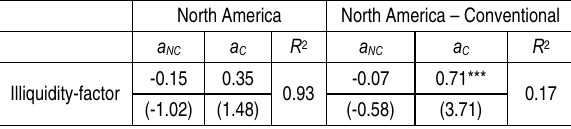
Table 4. Financial performance and